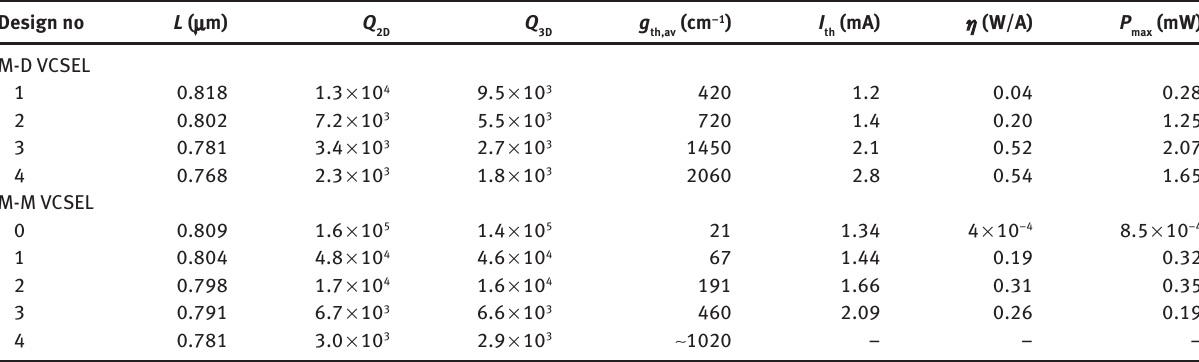
values given in the text. M